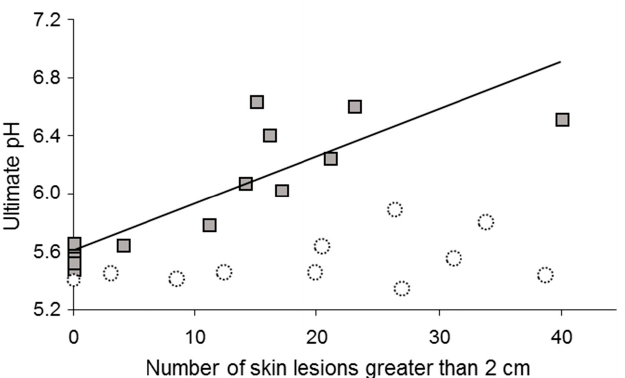
Figure 1. Squares: Piétrain × (Large White × Landrace) pigs. Number of skin lesions, indicative of agonistic interactions during mixed lairage at the abattoir (18 h), were correlated with the pH 24 h postmortem of the Adductor femoris muscle ( r = 0.89; p < 0.001). Adapted from [55,61], with permission from INRAE, 2020. Circles represent nonexisting hypothetical data from Hampshire pigs in which fighting is not expected to influence ultimate pH due to their high muscle glycogen content. If all points are combined irrespective of breed, the correlation is no longer significant showing the necessity to take influencing factors into account in the statistical model (see Section